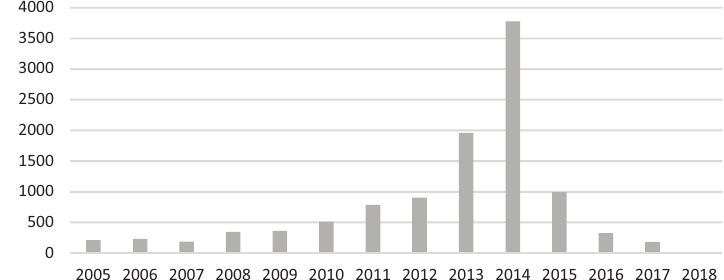
Figure 2. The number of new FinTech entrants in China (source: The China’s FinTech Companies Database, established by Tsinghua University, http://www.fintechdb.cn/)